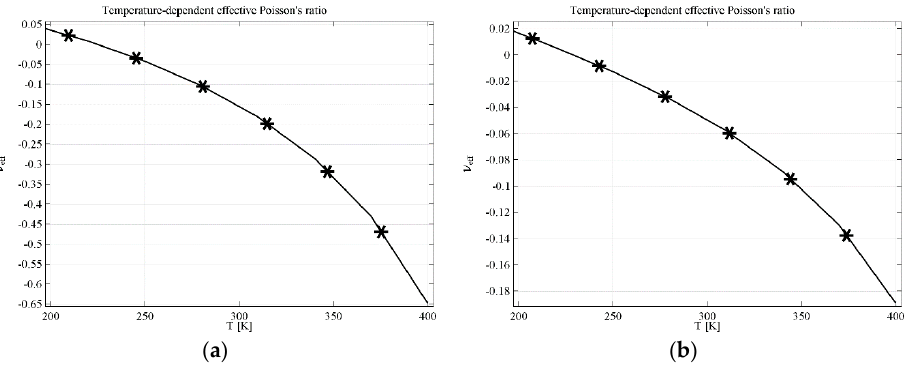
Figure 6. Effective Poisson’s ratio for RH geometry with filled voids in the case of ( a ) computational filling material; ( b ) real filling material. Parameters of the geometry: L = 1, B = 0.1, D = 0.15, G = 0.25, F = 0.16.